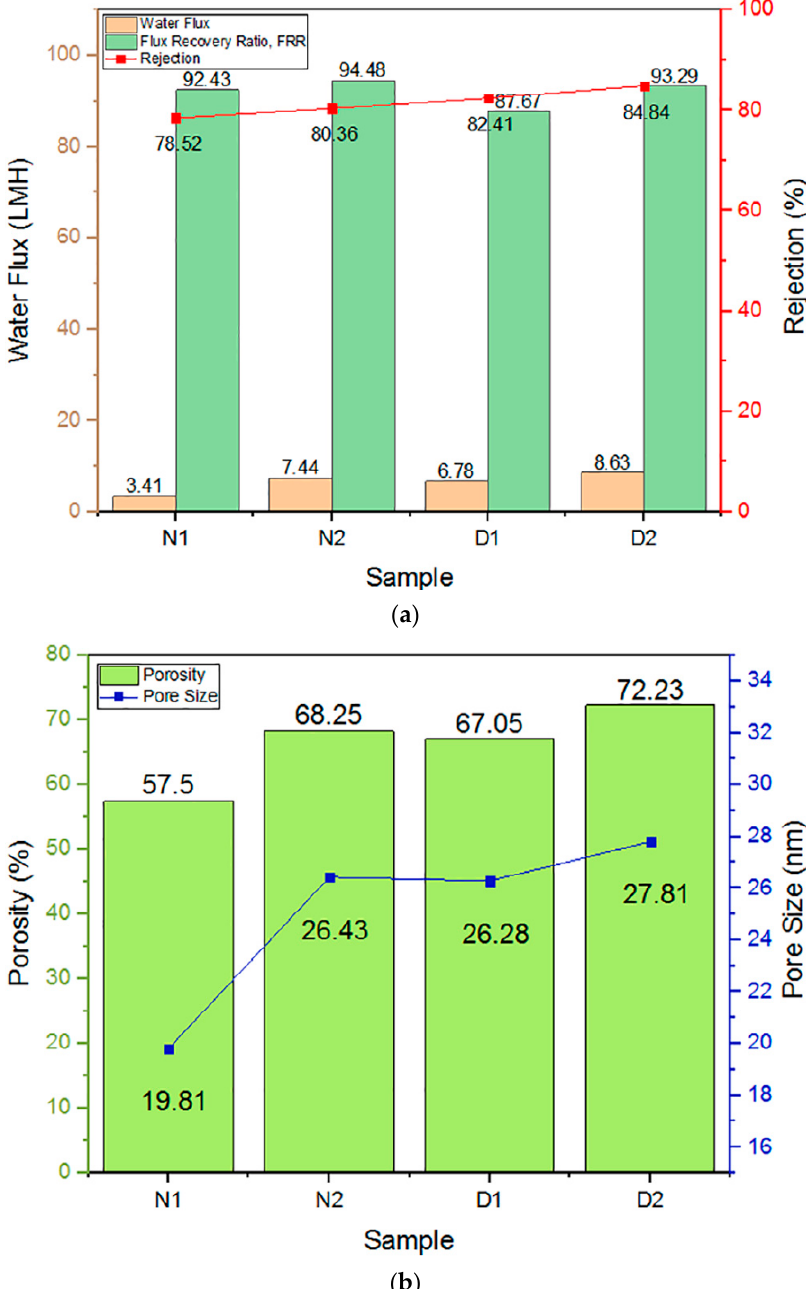
Figure 20. ( a ) Pure Water Flux, Rejection and Flux Recovery Ratio of Membrane. ( b ) Porosity and Pore Size of Membrane [88].